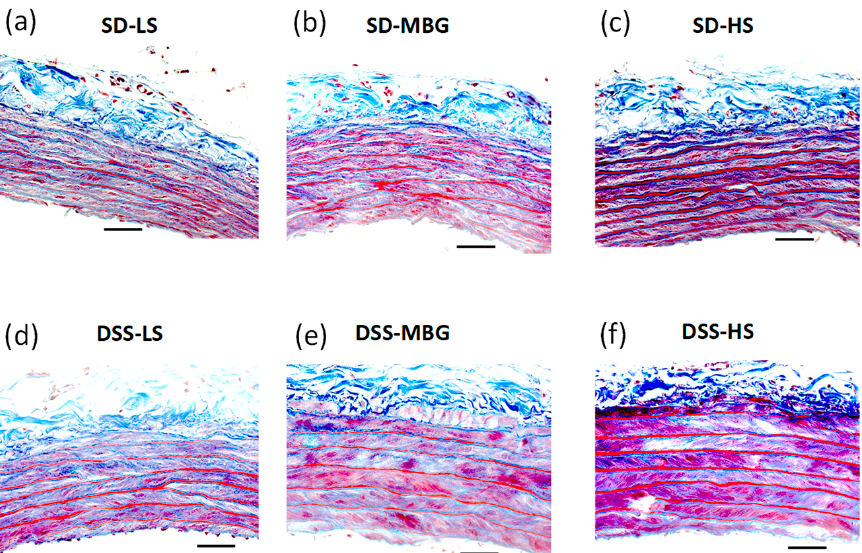
Figure 5. ( a – f ) Representative photomicrographs of aortae from each experimental group stained with Masson’s trichrome stain. Collagen in the aortic wall is stained blue; muscle and intracellular fibers are magenta. SD-LS ( a ), SD-MBG ( b ), SD-HS ( c ), DSS-LS ( d ), DSS-MBG ( e ), DSS-HS ( f ). SD, Sprague– Dawley rats; DSS, Dahl salt-sensitive rats; LS, low-salt diet; MBG, marinobufagenin; HS, high-salt diet. Scale bar is 50 µ